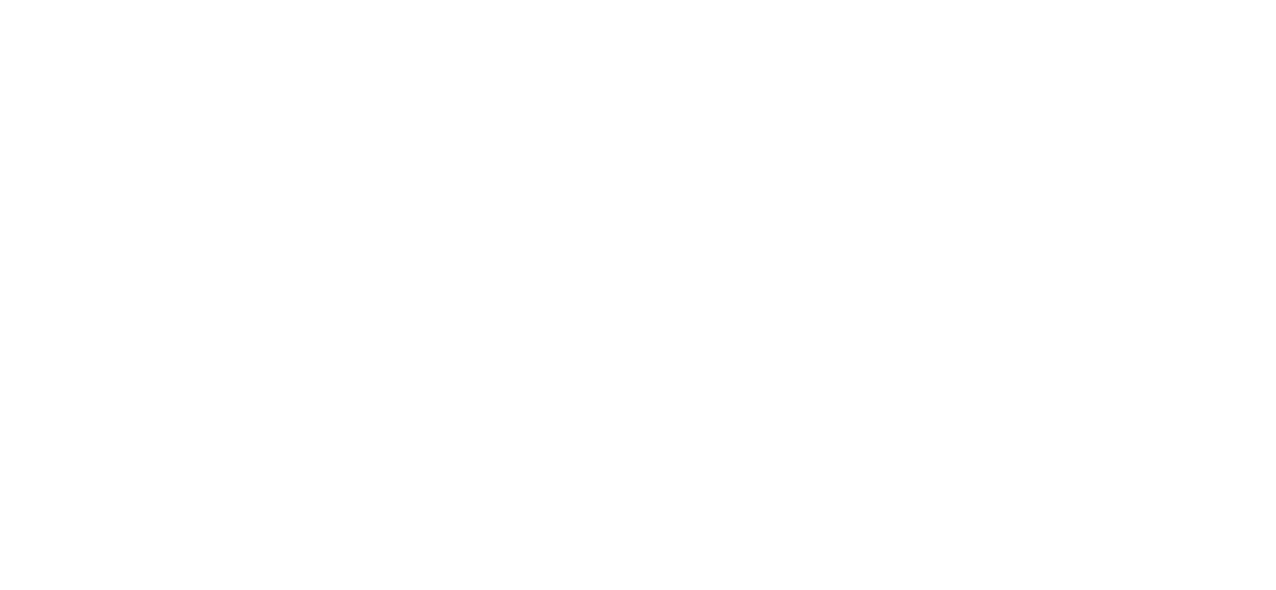
Frontiers in Pharmacology |